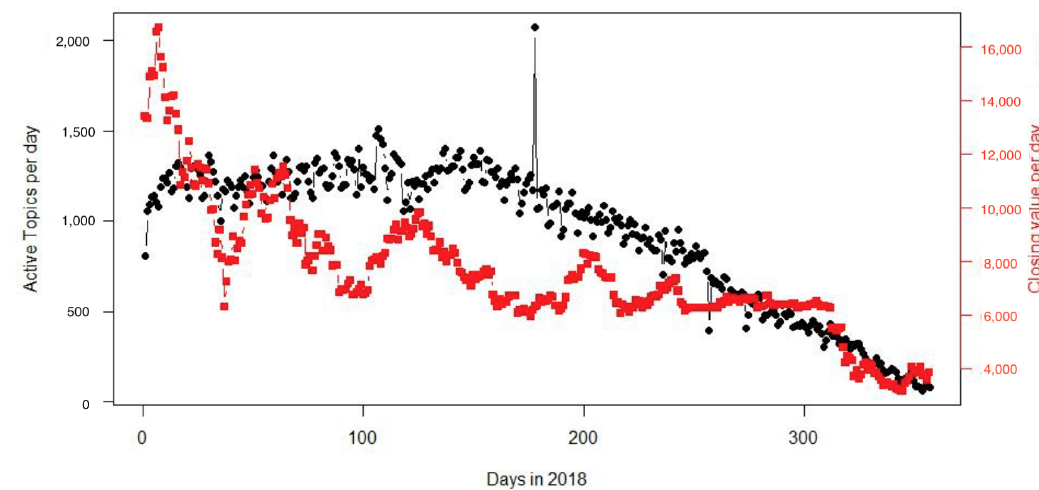
Figure 12. Comparison between the daily active topics and the closing value in 2018.